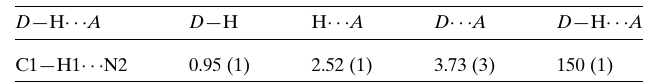
Table 1 Hydrogen-bond geometry (A˚ , (cid:4) ).